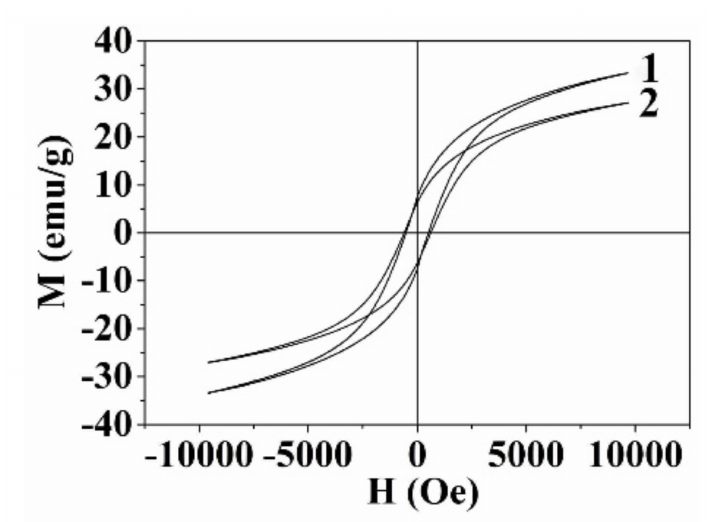
Figure 10. Magnetization curves of CoFe 2 O 4 (1) before and (2) after one gold deposition cycle, measured in magnetic field H = ± 10 kOe at 298